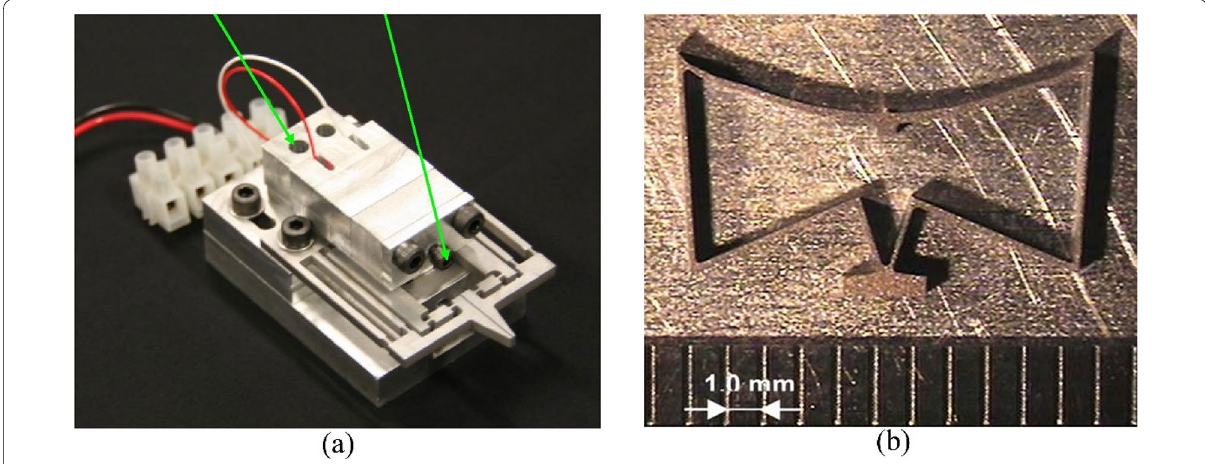
Figure 5 CMMs fabricated via wire EDM: ( a ) microgripper fabricated using Al plate [68] (©IEEE. Adapted by permission of IEEE. Permission to reuse must be obtained from the rightsholder), ( b ) variable-focus reflector fabricated using Ti plate [69] (©Elsevier. Adapted by permission of Elsevier. Permission to reuse must be obtained from the rightsholder)